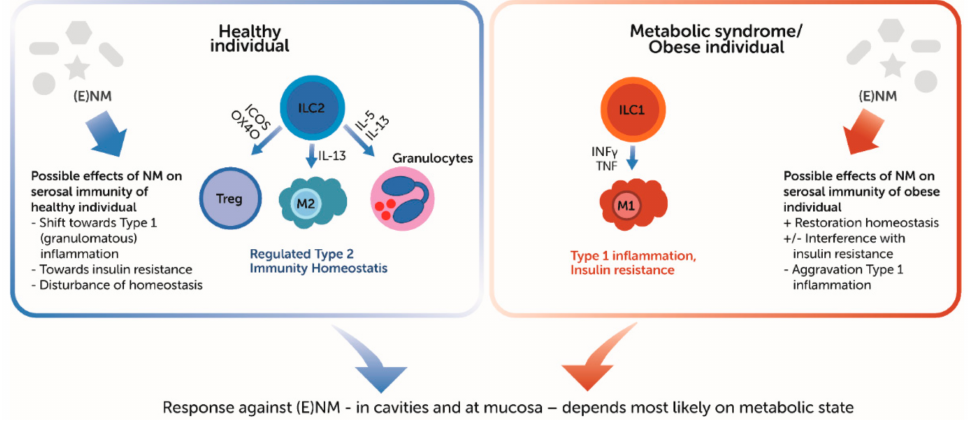
Figure 2. Regulation of visceral adipose immune function in health and metabolic disease. ICOS: inducible costimulatory molecule; ILC: innate lymphocyte; Treg: regulatory T cell; M: macrophage. Based on Figure 1 in